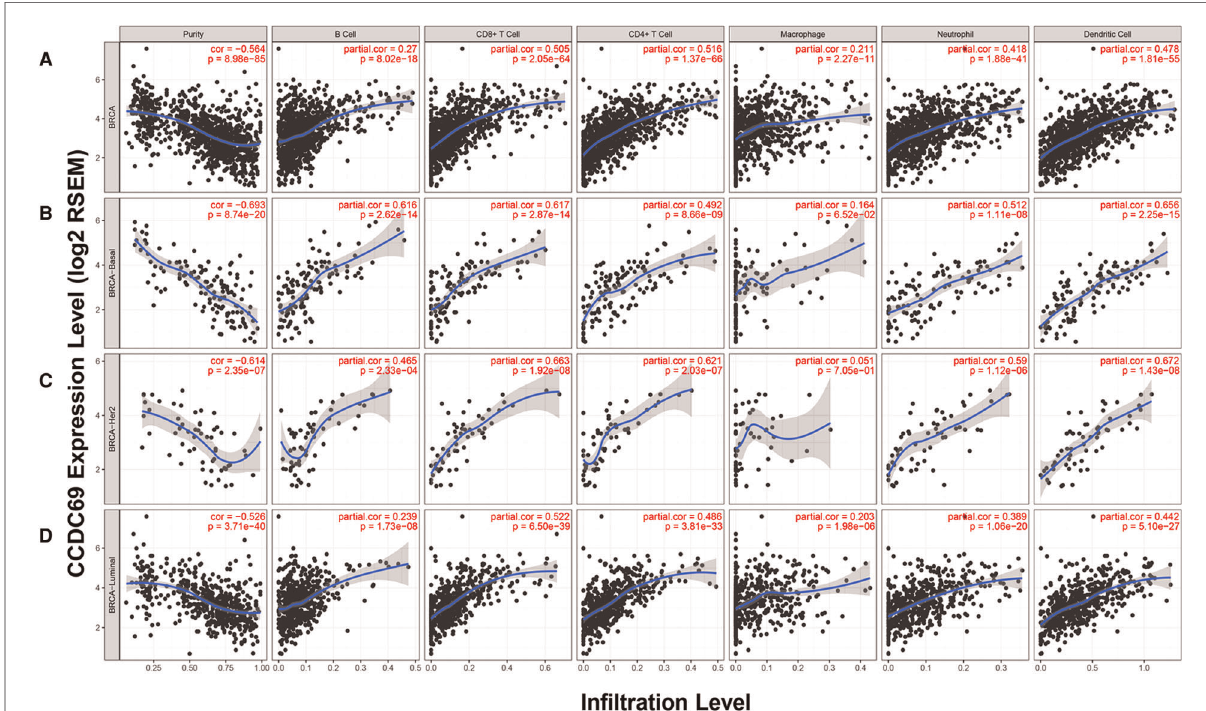
FIGURE 6 The expression of CCDC69 in the TIMER database was correlated with the in fi ltration level of TILs. ( A ) In BC, CCDC69 expression was signi fi cantly positively correlated with in fi ltration of B cells, CD8 + T cells, CD4 + T cells, macrophages, neutrophils, and dendritic cells. Analysis of TILS in fi ltration level and CCDC69 expression level in ( B ) basal subtype, ( C ) HER2 subtype and ( D ) luminal subtype in TIMER